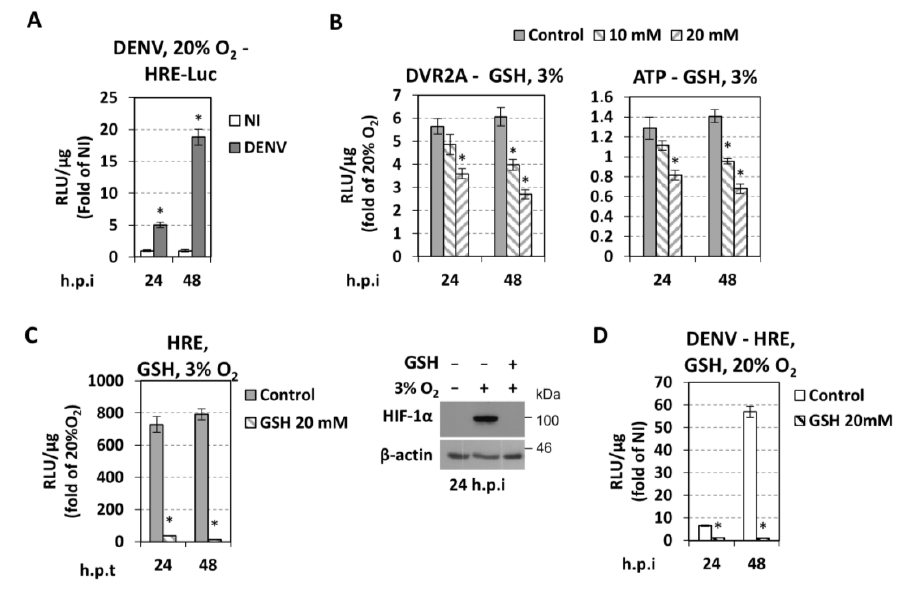
Figure 8. DENV induces hypoxic reprogramming—Role of redox homeostasis. ( A ) DENV upregulates HRE at 20% O 2 . Huh7 cells were transfected with the 9 × HRE-Luc construct (0.4 µ g/4 × 10 4 cells) and 4 h post-transfection infected, or not, with DENV (MOI 0.5). Cells were further incubated at 20% O 2 . HRE-dependent F-Luc activity was measured and expressed as RLU/ µ g of total protein amount. Values obtained from non-infected cells were set to one each time. * p < 0.001 vs. NI cells (Student’s t -test). ( B ) Glutathione reduces hypoxia-induced DENV replication enhancement. Huh7 cells, preincubated at 3% or 20% O 2 for 18 h, were infected with DVR2A (MOI 0.01). After virus inoculation, reduced glutathione (GSH) was added at the specified concentrations and cells were further incubated at the pre-incubation conditions. DVR2A-derived R-Luc activity and intracellular ATP levels were measured and expressed as RLU/ µ g of total protein. Values are expressed as ratio of the ones measured at 3% versus 20% O 2 . ( C ) Huh7 cells, were transfected with the 9 × HRE-Luc construct treated with glutathione (20 mM) and incubated at 3% or 20% O 2 . ( C , left ) HRE-dependent F-Luc activity was measured and expressed as RLU/ µ g of total protein amount. Values are expressed as ratio of the ones measured at 3% versus 20% O 2 . ( C , right ) Western blot analysis of HIF-1 α (top) and β -actin (bottom). The latter served as loading control. A representative experiment of 3 independent repetitions is shown. ( D ) Glutathione reduces DENV-mediated HRE activation at 20% O 2 . Huh7 cells were transfected with 9 × HRE-Luc construct and 4 h post-transfection were infected, or not, with DENV (MOI 0.5). Subsequently, cells were treated with glutathione (20 mM) and incubated at 20% O 2 . HRE-dependent F-Luc activity was measured and expressed as RLU/ µ g of total protein amount. Values from DENV-infected cells are presented as fold of the ones derived from non-infected cells. * p < 0.001 vs. control